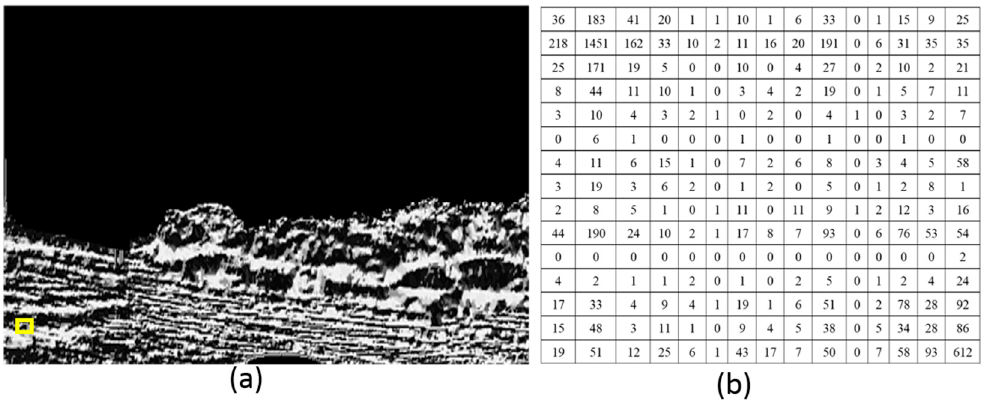
Figure 7. The GLCM when the center pixel is (275, 15). ( a ) The LBP image where the calculation block shown with the yellow rectangle is the calculation position; ( b ) The GLCM result.